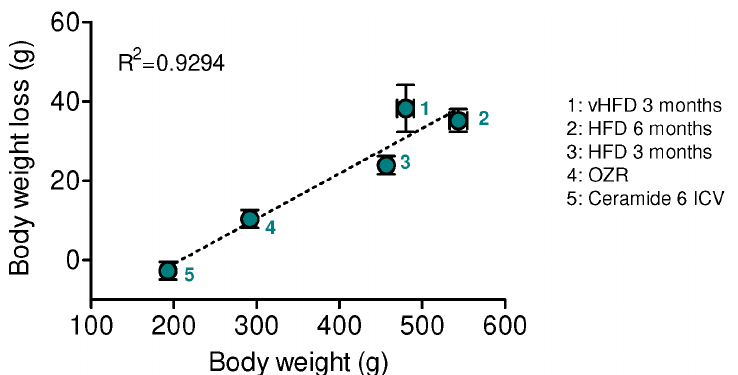
Figure 6. Effect of GRP78 overexpression in the VMH of different rat models of obesity. Correlation analysis (linear regression) between obesity degree and body weight loss in rats fed a vHFD (60% fat; labelled as 1 in the graph; n = 8 animals per group), rats fed a HFD for 6 months (45% fat; labelled as 2 in the graph; n = 20 animals per group) [23], rats fed a HFD for 3 months (45% fat; labelled as 3 in the graph; n = 27 animals per group) [23], obese Zucker rats (labelled as 4 in the graph; OZR; n = 37 animals per group) [17,23], and rats receiving intracerebroventricular (ICV) injections of ceramide 6 (labelled as 5 in the graph; n = 23 animals per group) [17], stereotaxically treated with Ad GRP78 adenoviruses into the VMH; in all the cases the adenoviral treatment lasted 7 days. Error bars represent the SEM.